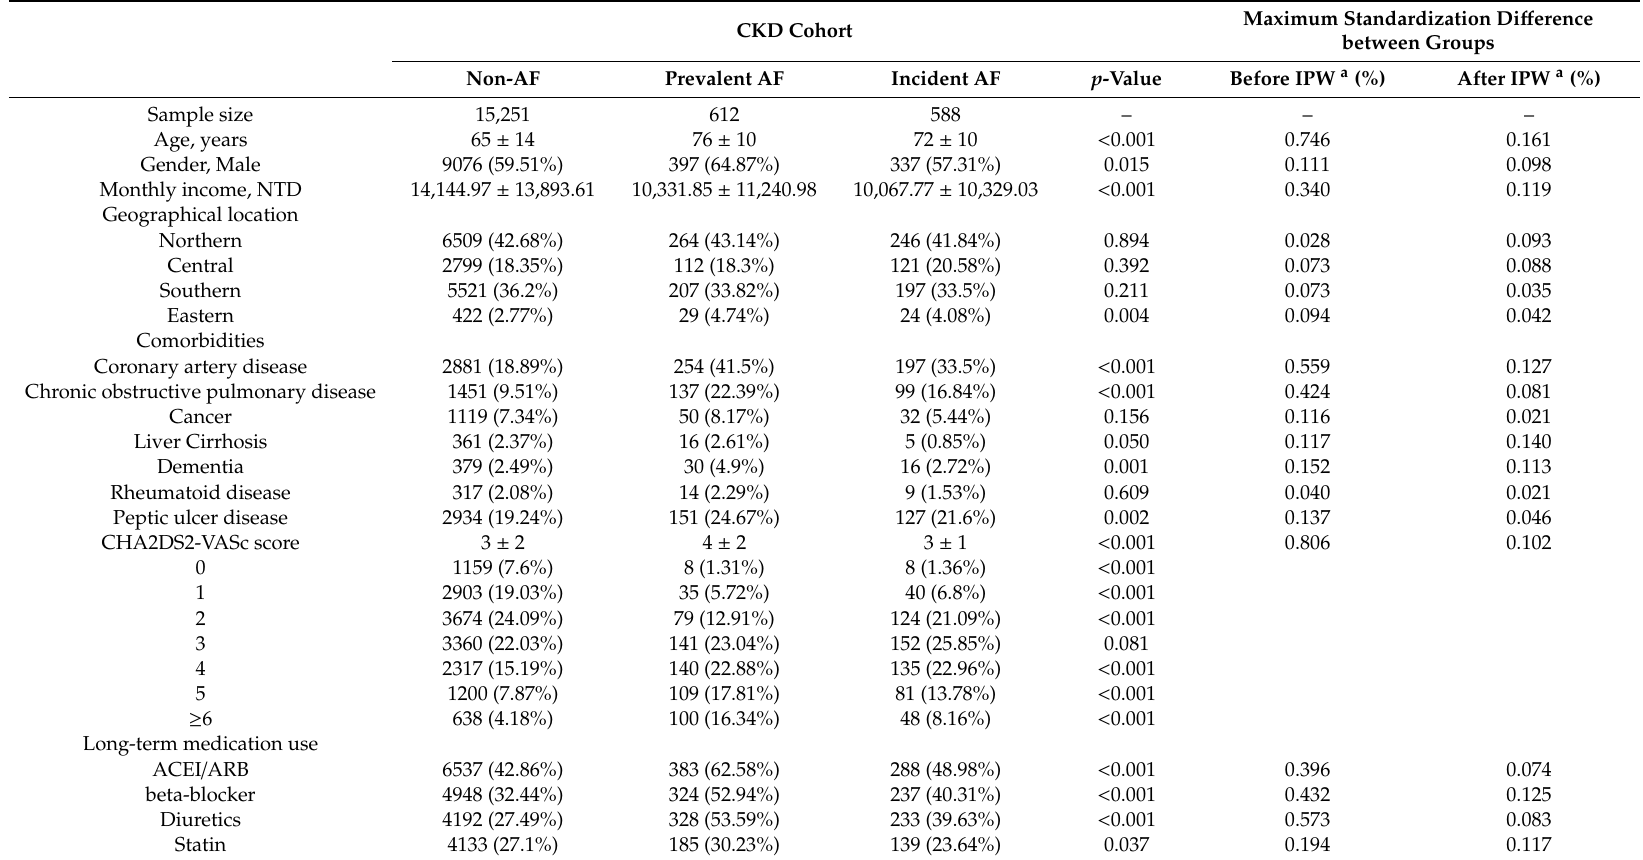
Table 1. Baseline characteristics of study population between the AF